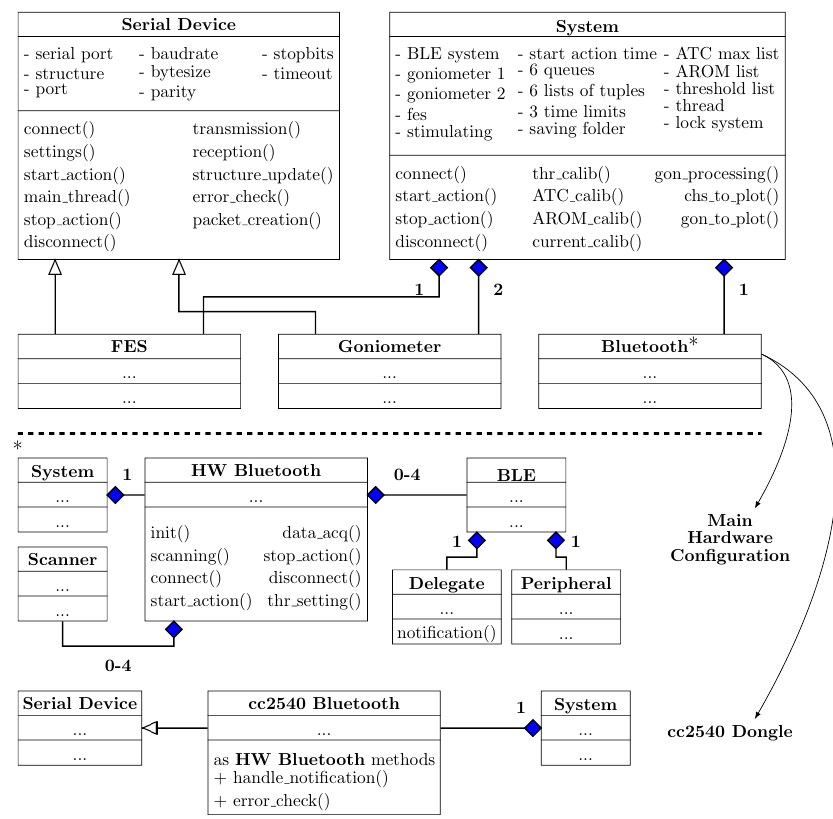
Figure 5. Classes diagram (UML) of our OO software organization. Bluetooth class implementation depends on system